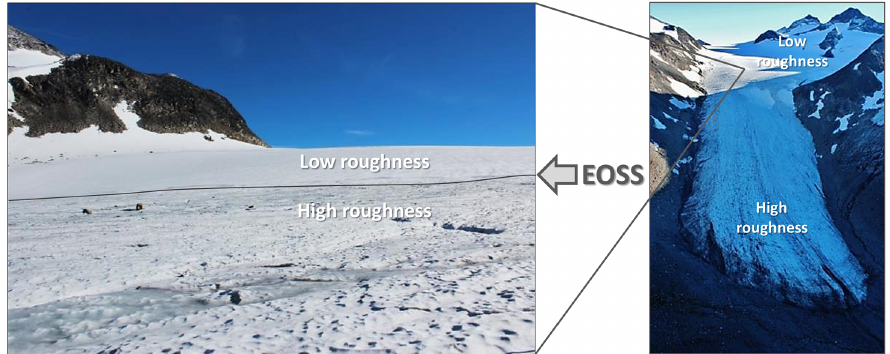
Figure 4. Photos illustrating roughness differences between ice or firn and seasonal snow. The images of Hellstugubreen were acquired on 12 September 2016 (DOY 256), when the end of summer snow line can be observed, often corresponding to the ELA (corresponding to no.8 in Fig. 2). Photos: Liss M. Andreassen,